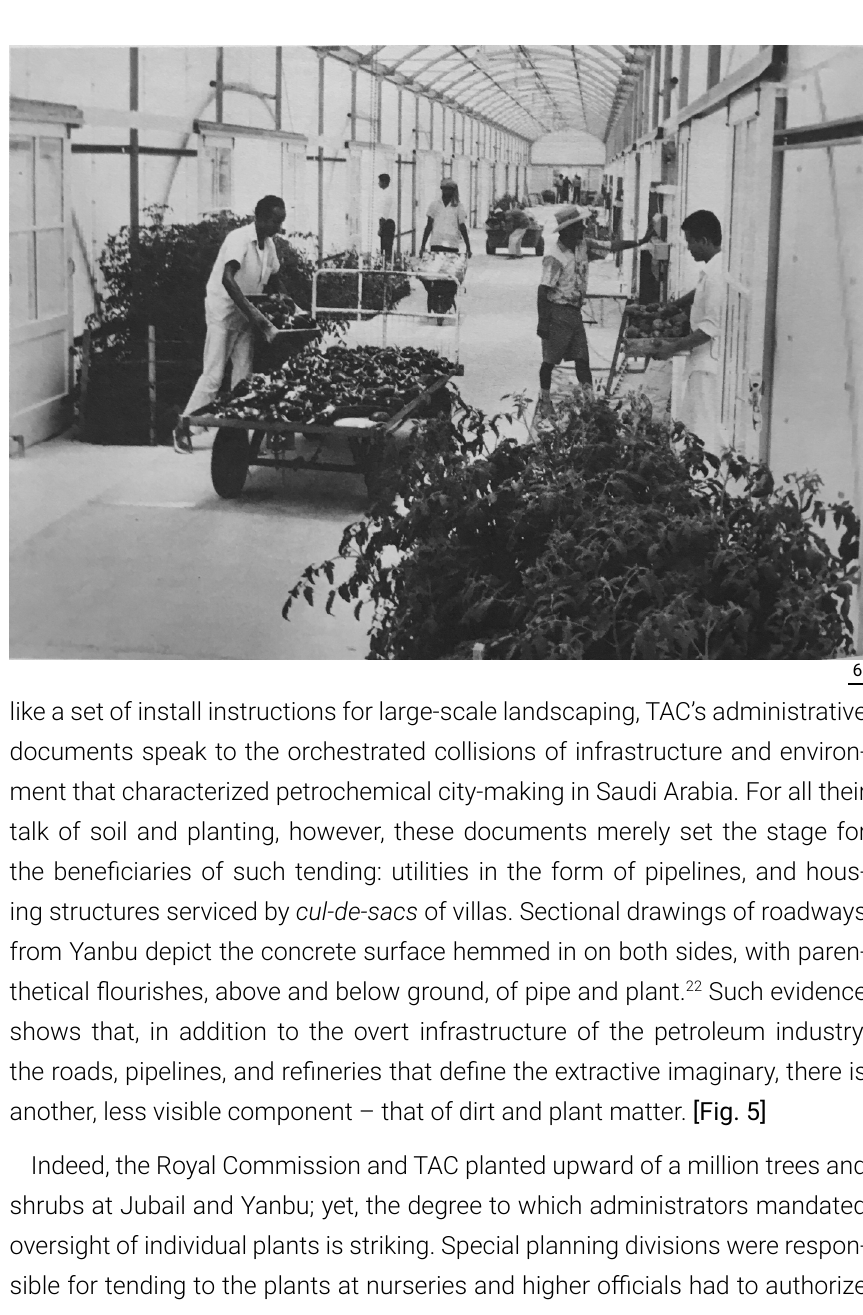
Fig. 6 Agricultural Experiment Station prepares plantings for eventual desert habitation. Source: Kath- leen Kelly and R.T. Schnadel- bach, Landscaping the Saudi Arabian Desert